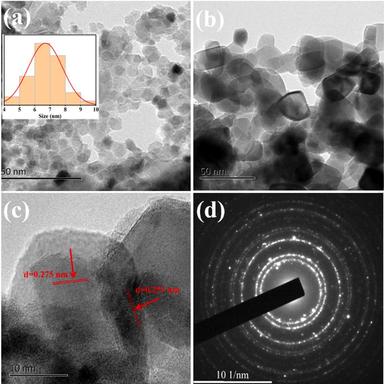
TEM (a and b), HRTEM (c) images and selected area electron diffraction (SAED) (d) pattern of CuO-NiO/NC catalysts prepared at 600 ◦C in air.